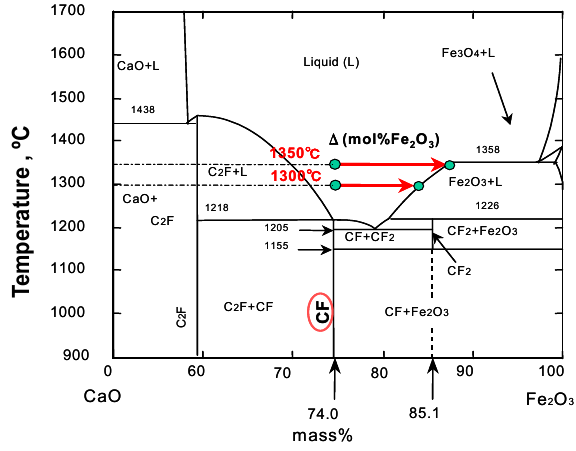
Figure 11. Phase diagram of CaO–Fe 2 O 3 .